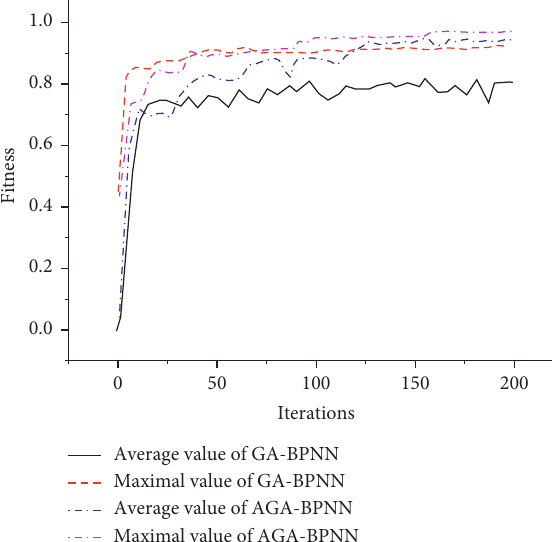
Figure 4: The changes and distribution curves of the maximal fitness and average fitness for the GA-PNN and